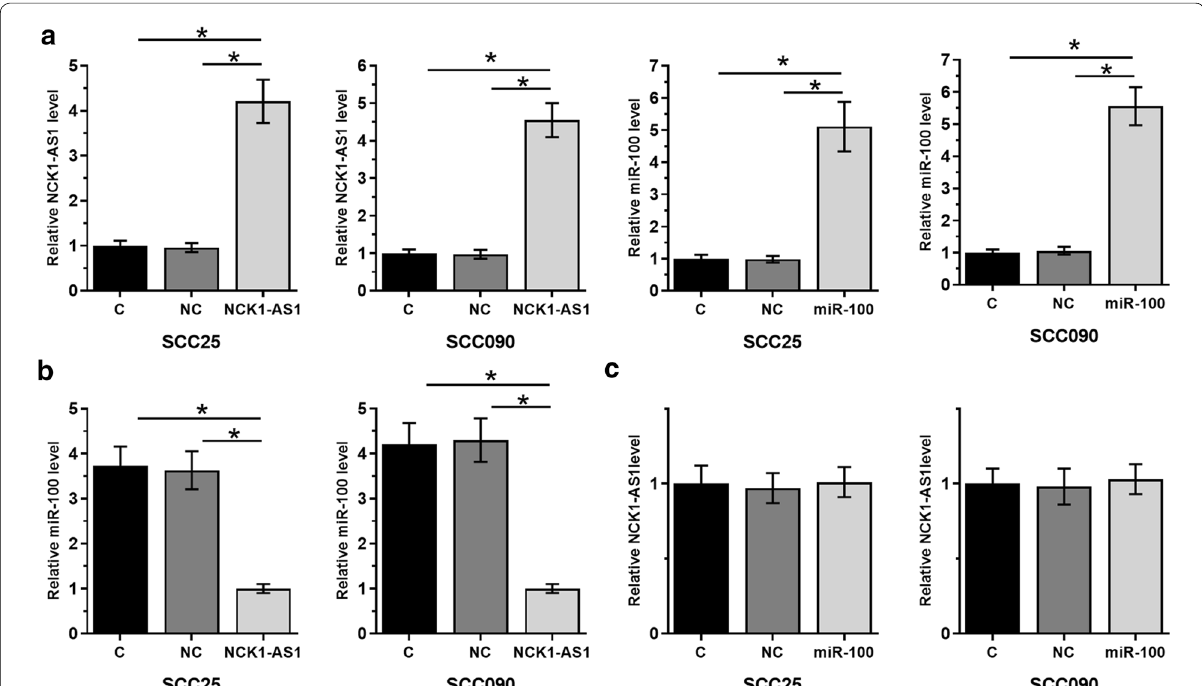
Fig. 4 Overexpression of NCK1-AS1 resulted in the downregulation of miR-100 in OSCC cells. In comparison to C and NC groups, the expression levels of NCK1-AS1 and miR-100 were significantly increased at 24 h after transfections ( a ), indicating successful transfections. In addition, cells with the overexpression of NCK1-AS1 showed significantly downregulated miR-100 ( b ). However, cells with the overexpression of miR-100 showed no significantly altered expression of NCK1-AS1 (C). * p <